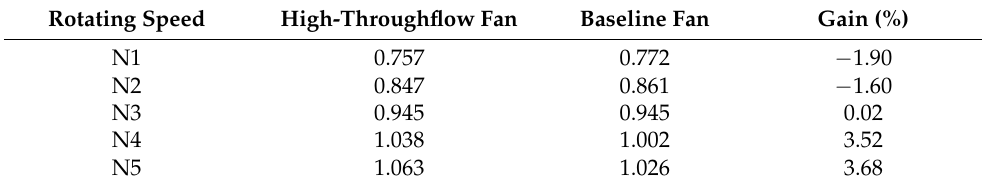
. . m choke / m design for the high-throughflow fan. Table 3. Gain of Table 3. Gain of  Rotating